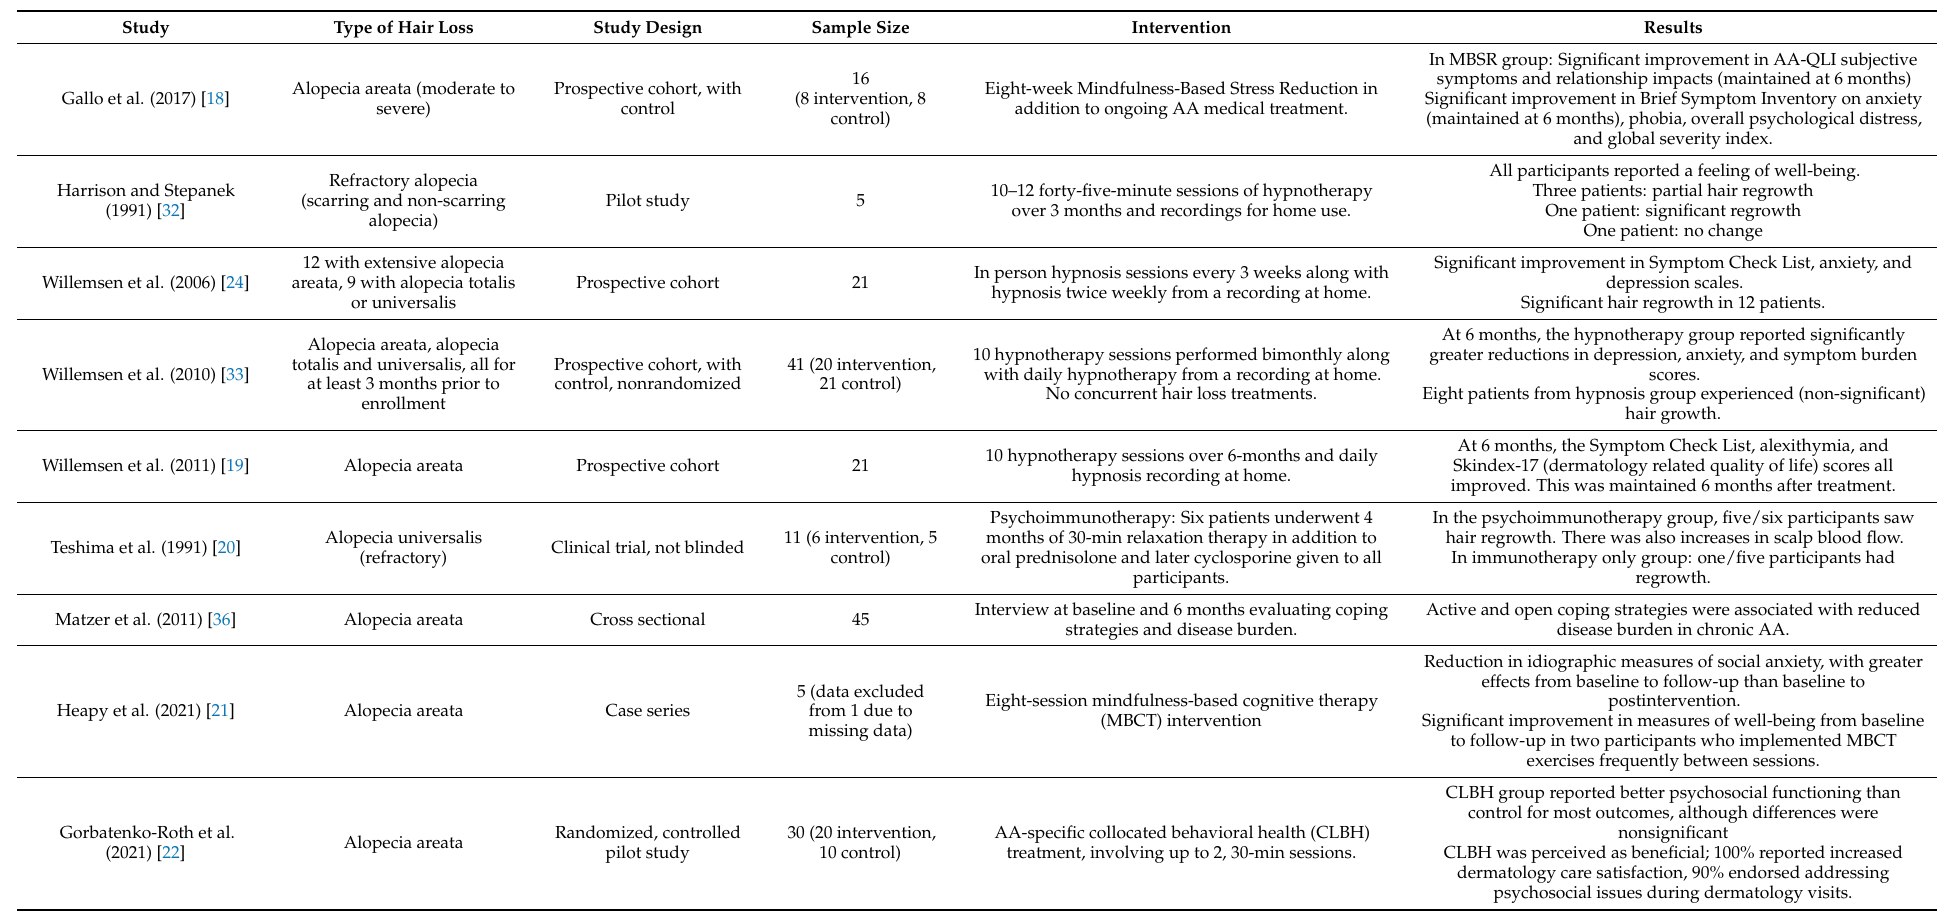
Table 1. Summary of psychological interventions studied in alopecia areata and scarring